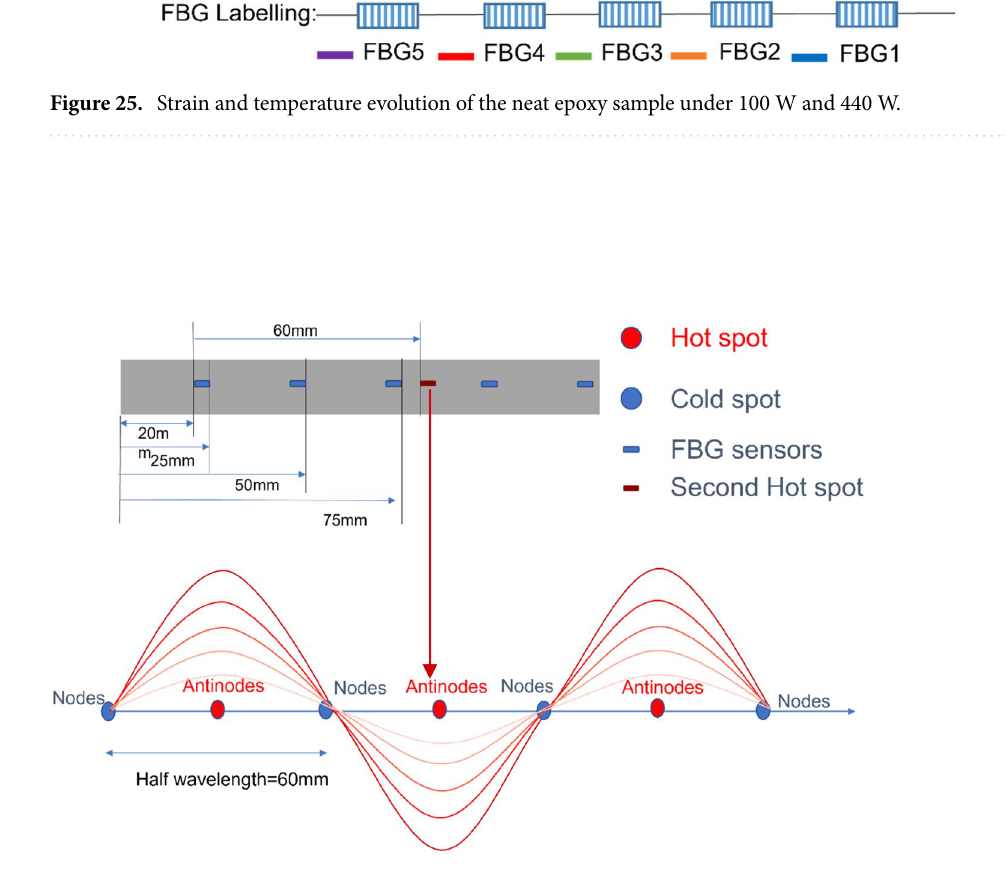
Figure 26. Schematic illustration of the location of FBG sensors on the neat epoxy surface, 20 mm apart, and standing waves formed in a microwave oven showing hot spots (antinodes) and cold spots